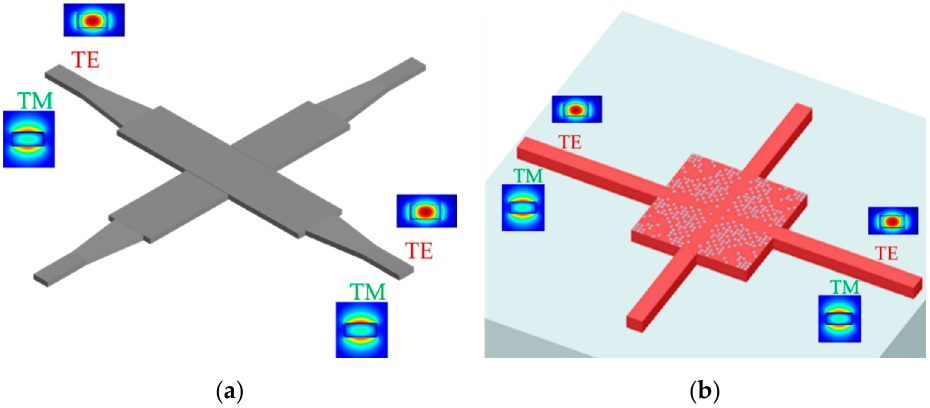
Figure 8. ( a ) Schematic of the polarization-multiplexed MMI silicon waveguide crossing; ( b ) top view of the polarization-multiplexed inverse-designed silicon waveguide crossing. of the polarization-multiplexed inverse-designed silicon waveguide